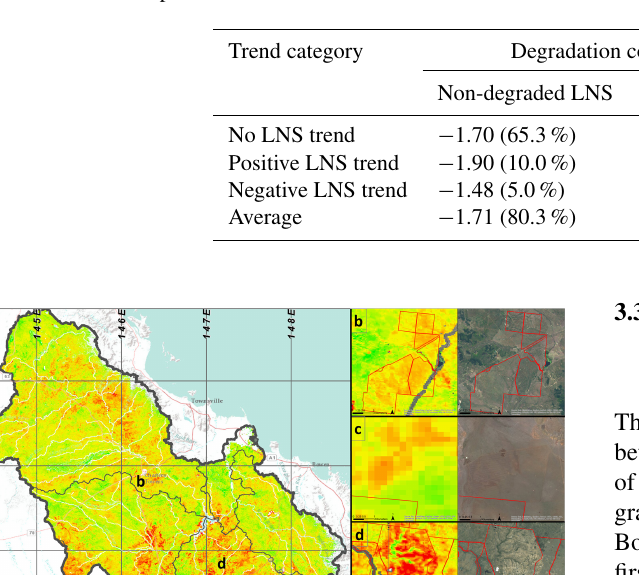
Table 2. Average LNS (MgCm − 2 yr − 1 ) in the Burdekin Dry Tropics (BDT) region for all six combinations of degraded and non-degraded LNS conditions and three interannual LNS trends – no trend and positive and negative trends. The percentage of BDT area in each land condition is shown in parentheses.